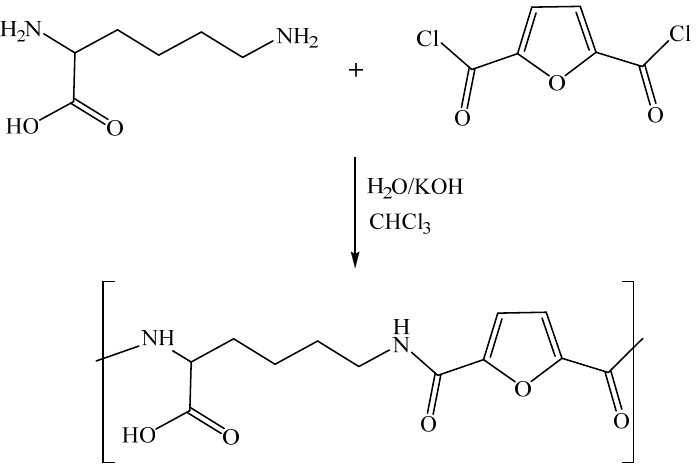
Figure 1. Synthesis of the polyamide by interfacial polycondensation of L-lysine and 2,5-furyl dichloride.